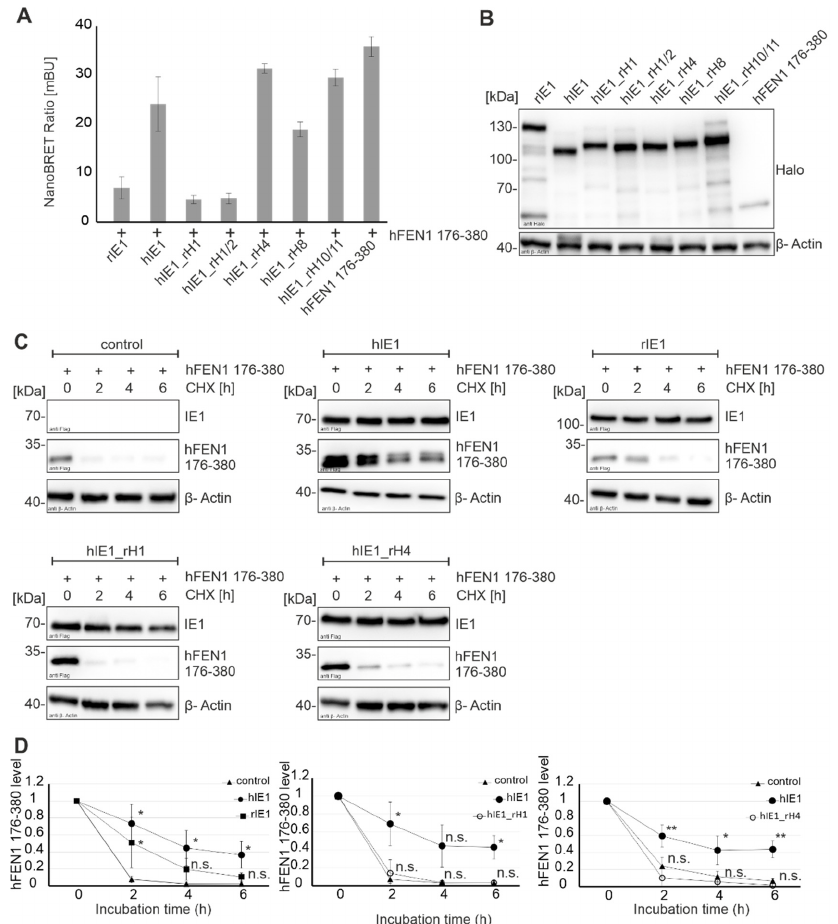
Figure 5. Functional analysis of hIE1_rH mutants with hFEN1. ( A ) NanoBRET measurement of IE1 homologs and hFEN1 was performed. HEK293T cells were cotransfected with Halo tagged IE1 ver- sions, and Luc tagged hFEN1 176-380 for 24 h. Signals of acceptor and donor were measured at 618 nm and 448 nm for 5 sec with the Hidex Chameleon plate reader after 4 h incubation with the Halo ligand. ( B ) Protein expression in NanoBRET lysates was controlled via Western blot analysis. The proteins were stained with the mAB Halo antibody and mAB β -actin. ( C ) Stabilization of hFEN1 176-380 by IE1 homologs and hIE1_rH mutants was investigated by cotransfection of HEK239T cells with Flag-tagged IE1 homologs or hIE1_rH mutants and Flag-tagged hFEN1 1 176-380 for 24 h. Cells were treated with cycloheximide (CHX, 10 µg/mL) and harvested after 0, 2, 4, and 6 h of incubation. Western blot analyses were performed to detect Flag hFEN1 176-380, hIE1, hIE1 mutants and β - actin ( D ) Quantification of hFEN1 degradation in independent experiments (rIE1 n = 4, hIE1_rH1 and hIE1_rH4 n = 3) is represented by mean value ± SD. Statistical significances of hFEN1 176-380 stabilization by IE1 homologs and IE1_rH mutants compared to control were calculated using two- tailed Student’s t -test and are represented by asterisks: * p < 0.05; ** p < 0.01; n.s. = non-significant.